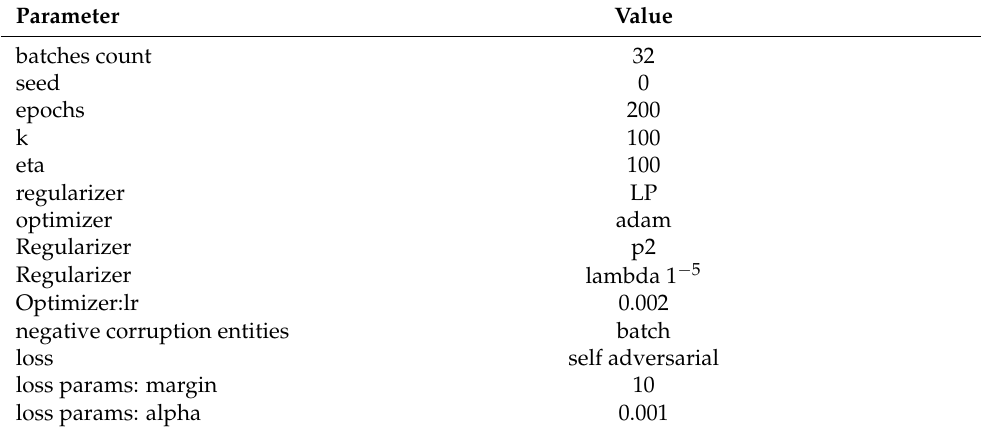
Table 2. Hyper-parameter setting for TransE model.